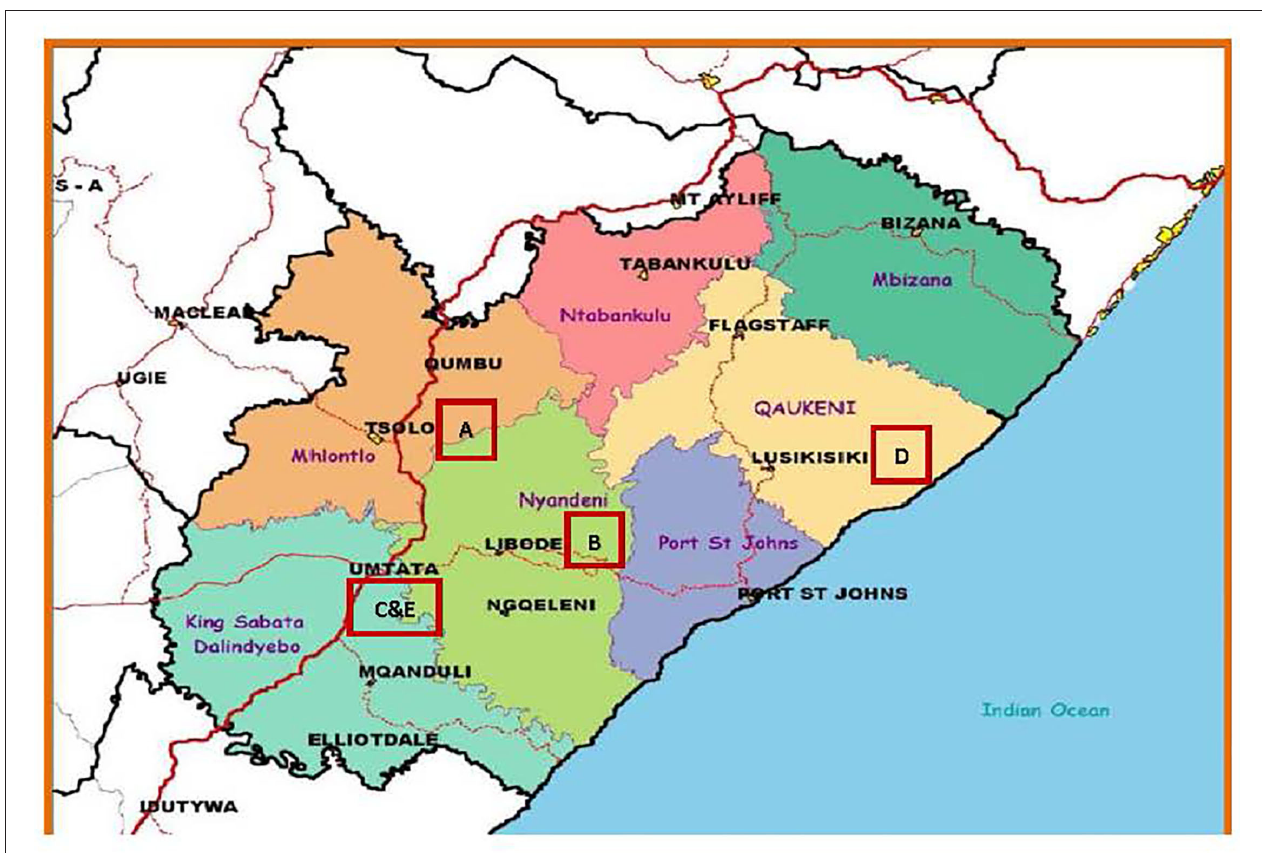
FIGURE 1 | Location of different hospitals labeled as alphabets A, B, C, D, and E in the red squares or rectangles in the Oliver Tambo District in the Eastern Cape in South